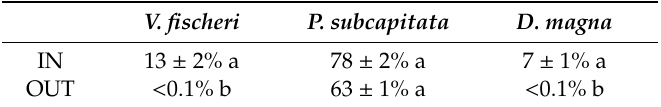
Table 5. Ecotoxicological risk assessment of wastewaters before and after the CW treatment. Di ff erent letters indicated that the di ff erences among the means were significant ( p -value <